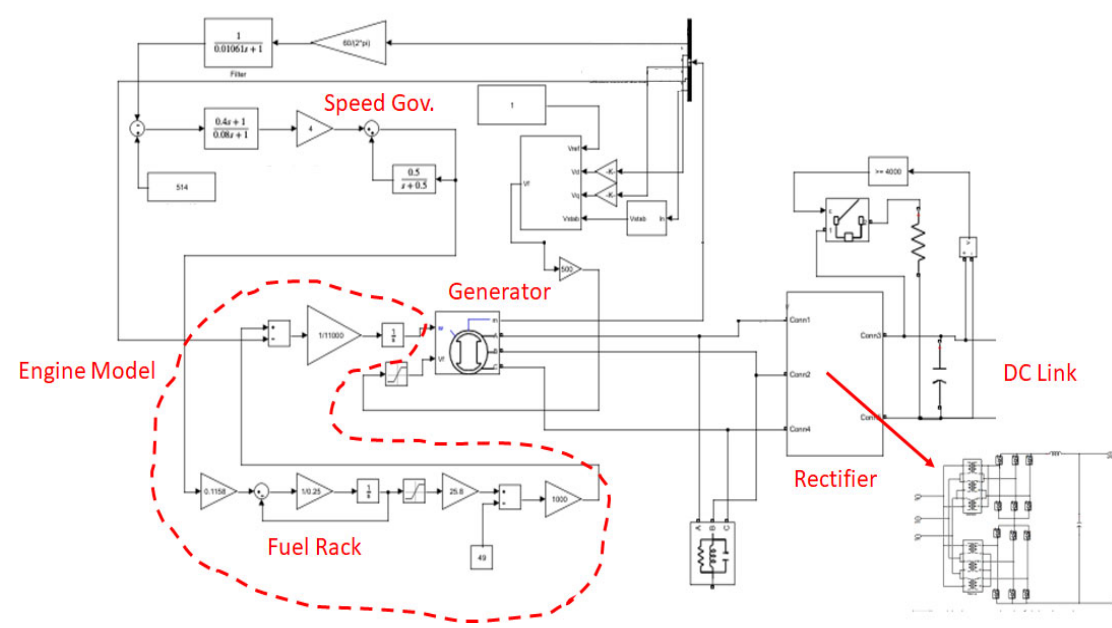
Figure 6. Diesel Engine/Generator/Rectifier Simulink TM Model.